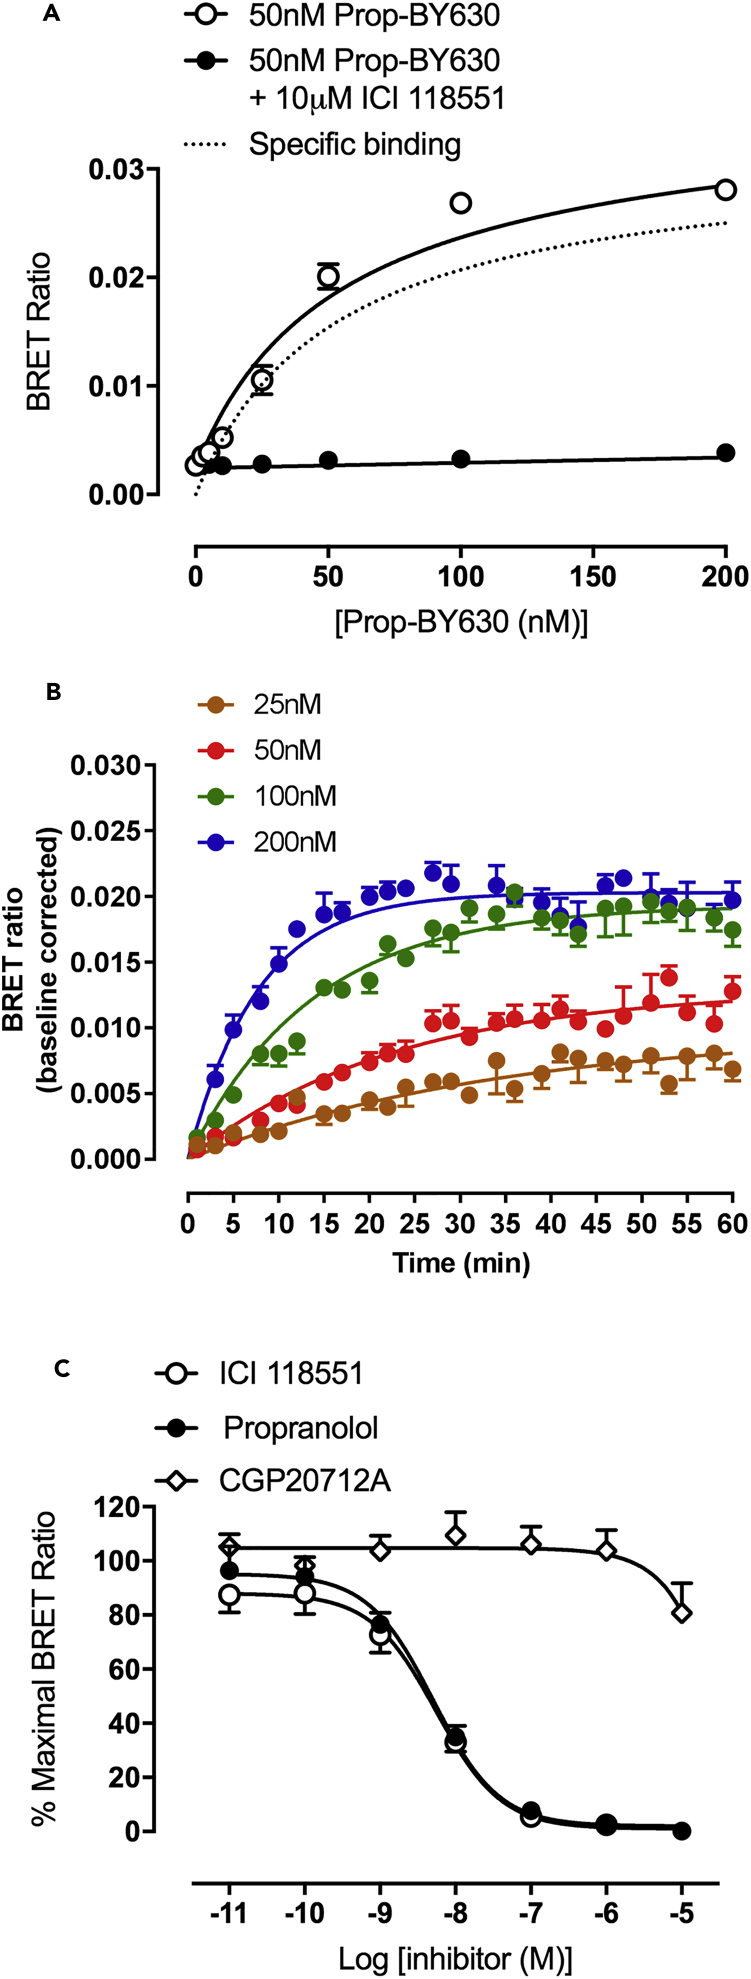
Quantitative Analysis of Ligand Binding to NanoLuc-Tagged Human β2-Adrenoceptors Expressed in MDA-MB-231HM Cells Using NanoBRET(A) Binding of increasing concentrations of Propranolol-(β-Ala-β-Ala)-X-BODIPY630/650 (Prop-BY630) to NanoLuc-tagged human β2-adrenoceptors in MDA-MB-231HM cells measured using a CLARIOstar plate reader. Non-specific binding was defined with 10 μM unlabelled ICI 118551. Data are mean ± SE from 6 separate experiments. Total (open circles) and non-specific binding (closed circles) curves were fitted simultaneously as described in the Transparent Methods. The dotted line shows the specific binding component derived from this analysis.(B) Real-time kinetic analyses of Prop-BY630 binding to NanoLuc-tagged human β2-adrenoceptors expressed in MDA-MB-231HM cells using 25, 50, 100, and 200 nM fluorescent ligand. BRET ratios for kinetic studies have been baseline-corrected to specific binding (after subtraction of non-specific binding) at time 0. Data are mean ± SE of triplicate determinations in a representative experiment. Similar data were obtained in 4 additional experiments.(C) Inhibition of the specific binding of 50 nM Prop-BY630 to NanoLuc-tagged human β2-adrenoceptors in MDA-MB-231HM cells by increasing the concentrations of ICI 118551, un-labelled propranolol, and CGP20712A. Data are mean ± SE from 5 separate experiments.